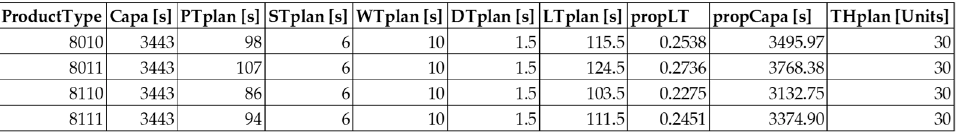
Figure 17. Data to create the production schedule with planned maintenance for test series two.